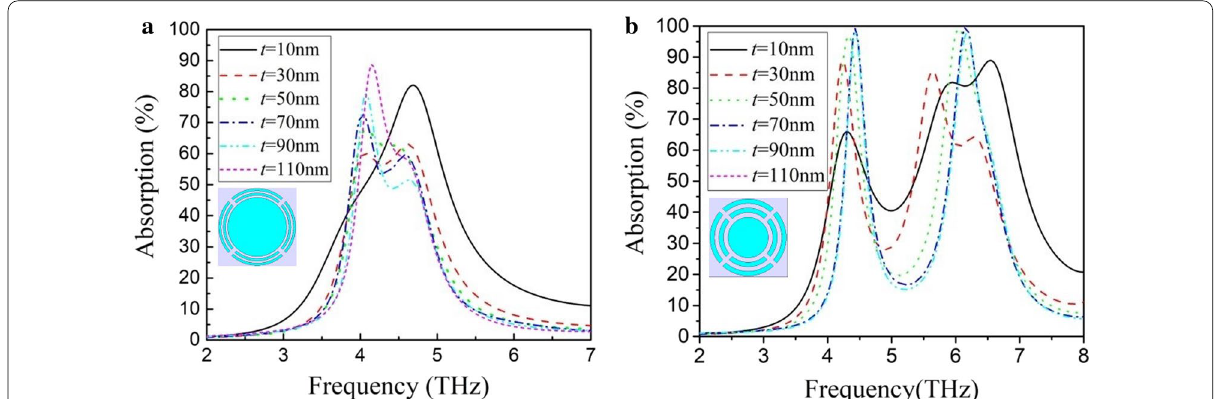
Fig. 5 THz wave absorption of periodic structures of a combination of two split-rings and an Al disk with different thicknesses ( t ). a Two split-rings have a ring width of 1 μm, an opening width of 2 μm and an outer radius of 17 μm and 15 μm, respectively. The Al disk has a radius of 13 μm. b Two split-rings have a ring width of 2 μm, an opening width of 2 μm and an outer radius of 17 μm and 13 μm, respectively. The Al disk has a radius of 9 μm